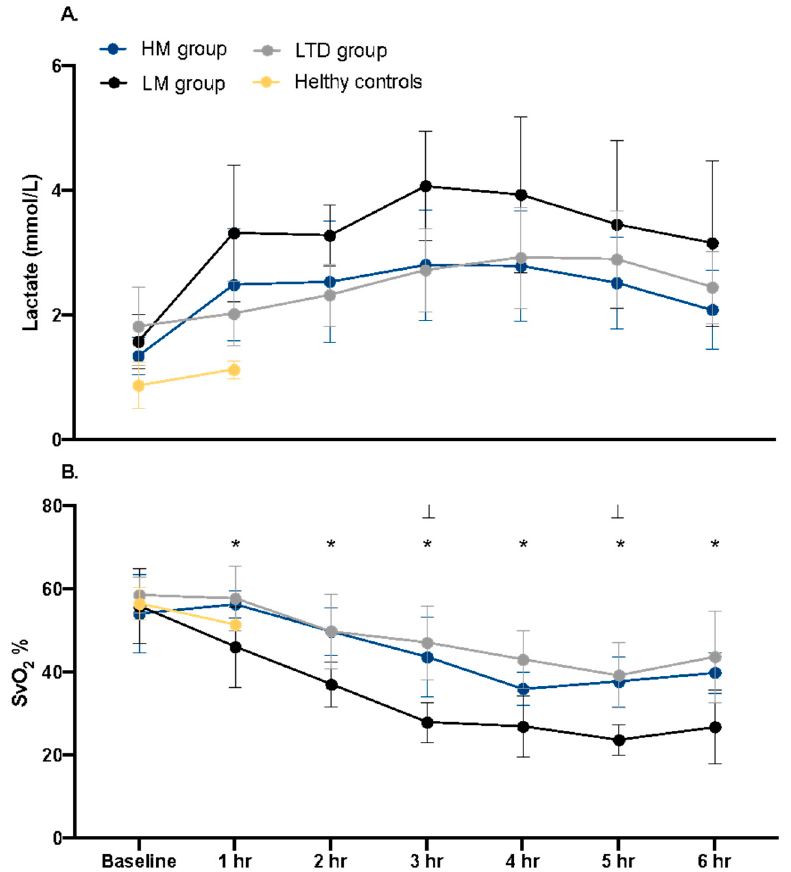
Figure 2. Part ( A ). Lactate concentration (mmol/L) in arterial blood at baseline and every hour during the observation time in the three groups, and at baseline and after 1 h of observation in healthy controls group. Part ( B ). SvO 2 (%) at the baseline and every hour during the observation time in the three groups, and at baseline and after 1 h of observation in healthy controls group. Data presented as mean and standard deviation. p value < 0.05 for the comparison between LTD and LM group indicated with *, for the comparison between HM and LM group indicated with ⊥ .